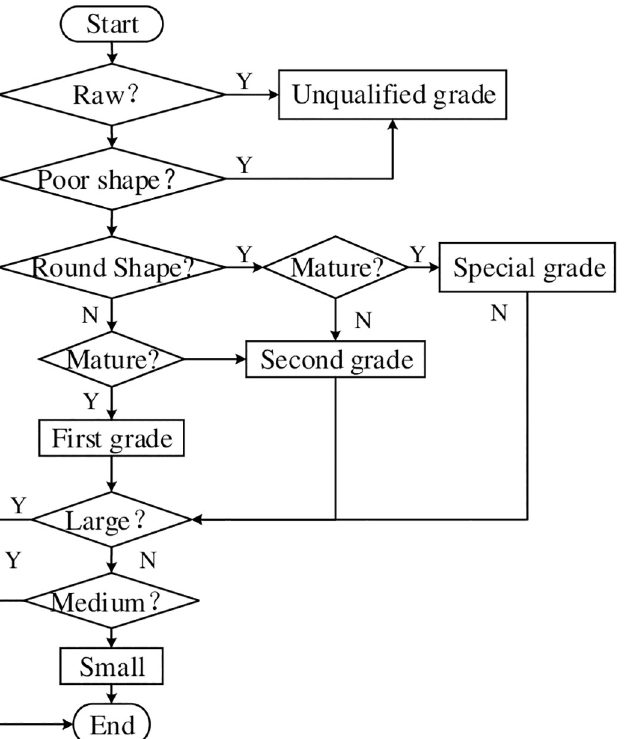
Fig 6. The flow of the comprehensive